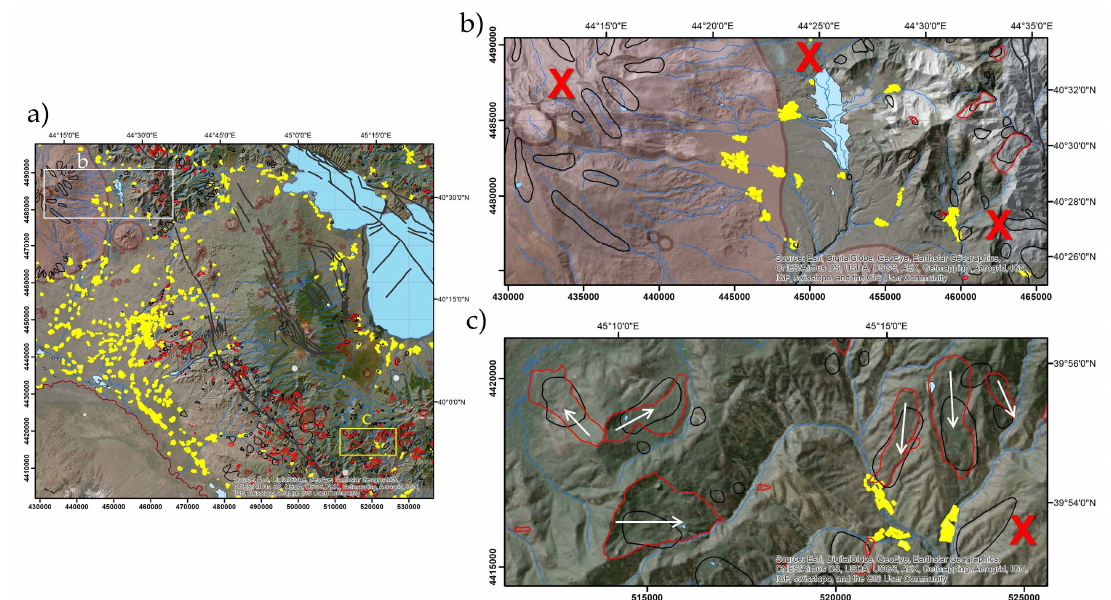
Figure 7. Major differences between landslides recorded in the Matossian catalogue (red polygons) and the Georisk catalogue (black polygons). ( a ) The generalized map shows the locations of ( b ) and ( c ). In ( b ) and ( c ), ‘X’ marks zones where morphologies recorded as landslides in the Georisk catalogue were not considered as such in the Matossian catalogue. ( b ) Near Aragats volcano, Georisk landslides were excluded from the Matossian catalogue because we interpreted the morphologies as representative of moraine material (especially at elevations above 3000 m). ( c ) Comparison of Matossian and Georisk landslide outlines shows that the latter include the landslide deposits, but often not the scarp areas.